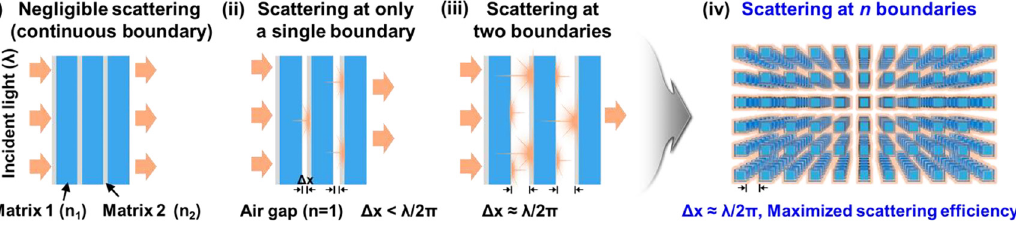
Figure 7: Schematic illustrations showing engineering strategy for controlling scattering based on dependence of light scattering effect on distance between neighboring boundaries. Reprinted with permission from Ref.